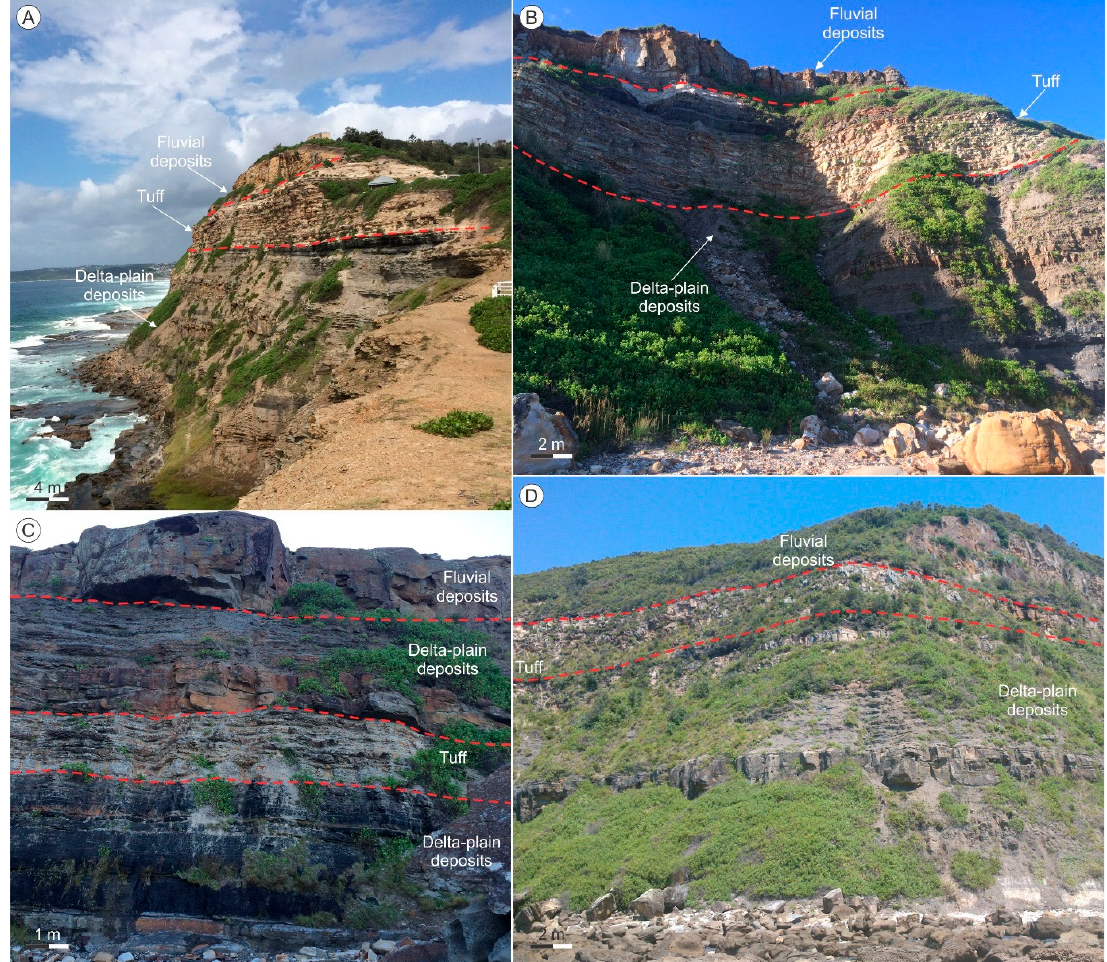
Figure 3. Outcrop photographs of the sedimentary succession in the NSB. Note the upwards shift in the environments of deposition, from deltaic to fluvial. ( A ) Bar Beach. ( B ) Merewether Beach. ( C ) Dudley North. ( D ) Dudley South. Note also the presence of thick and laterally continuous tuff deposits at the boundary between the underlying deltaic and the overlying fluvial deposits.